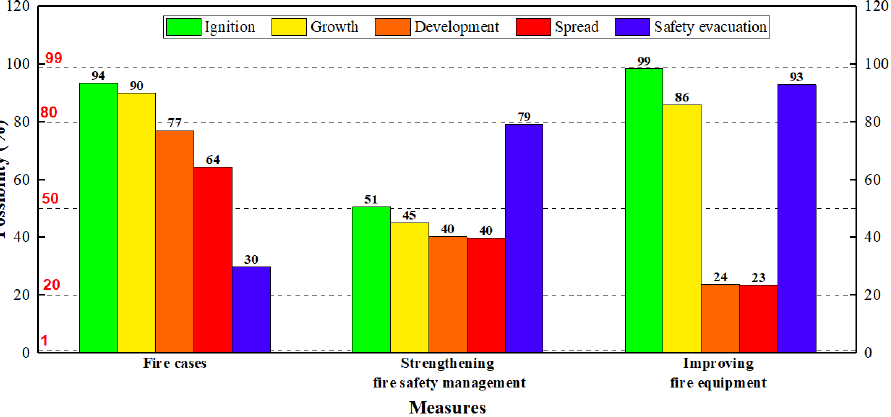
Figure 9. The risk change with two types of measures: strengthening fire safety management or improving fire equipment.